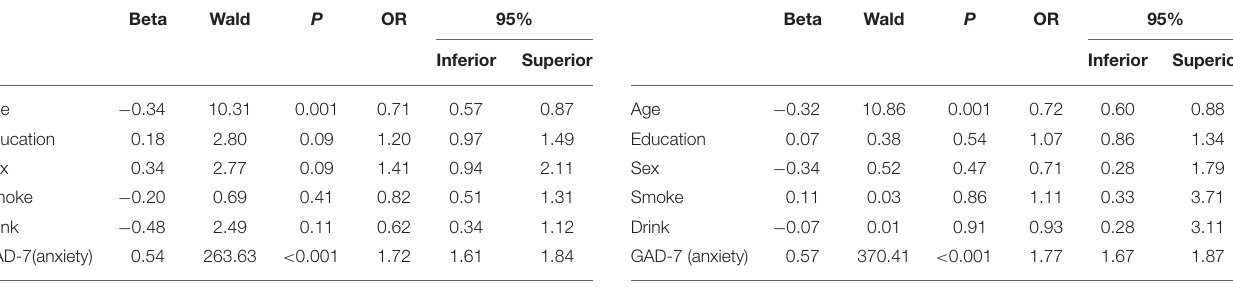
TABLE 5 | Influencing factors of depression in Doctor FL.